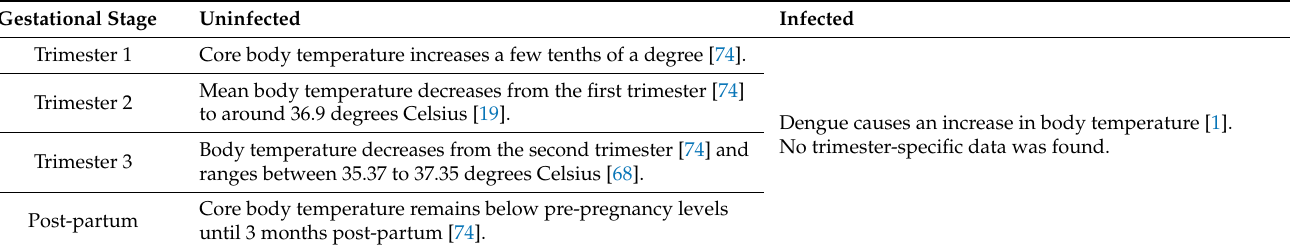
Table 6. Uninfected versus dengue-infected thermoregulatory changes in pregnant